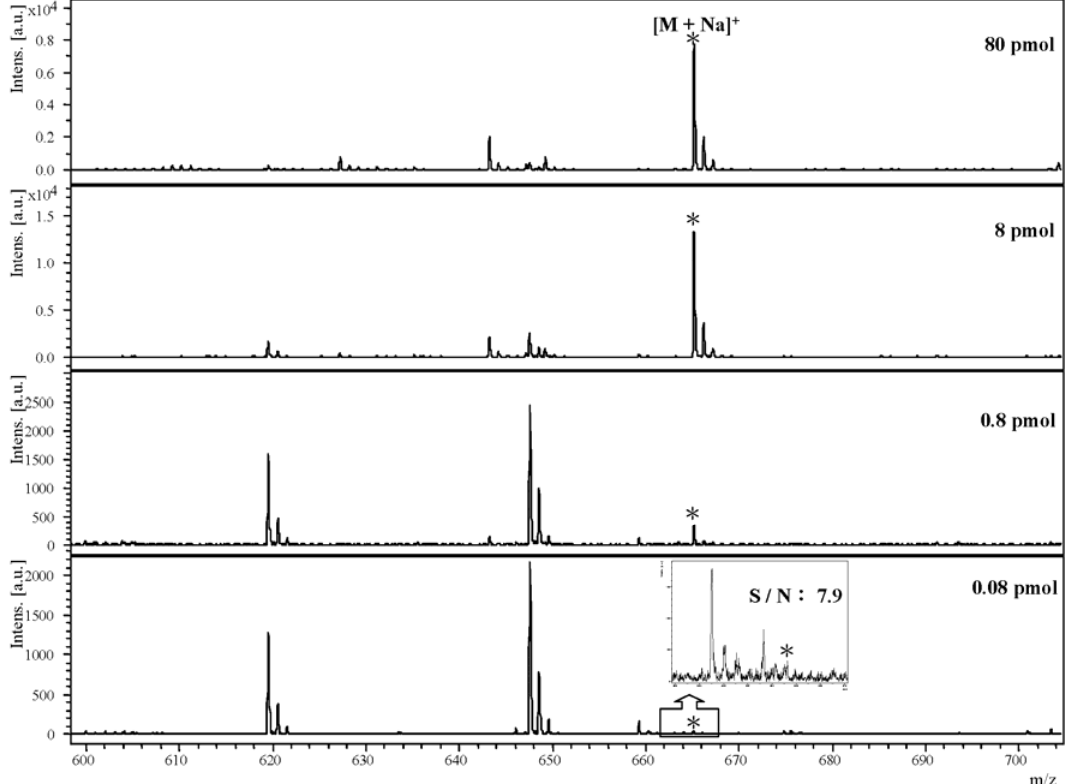
Figure 5. MALDI–TOF MS of maltotrio–naphthimidazole with loading of 80, 8, 0.8 and 0.08 pmol, respectively, using 50 nmol of 2,5-DHB as a matrix. The asterisk ( ＊ ) denotes the [Glc –NAIM + Na] + ion at m/z 665.2. The signals of matrix become obvious at low 3 analyte